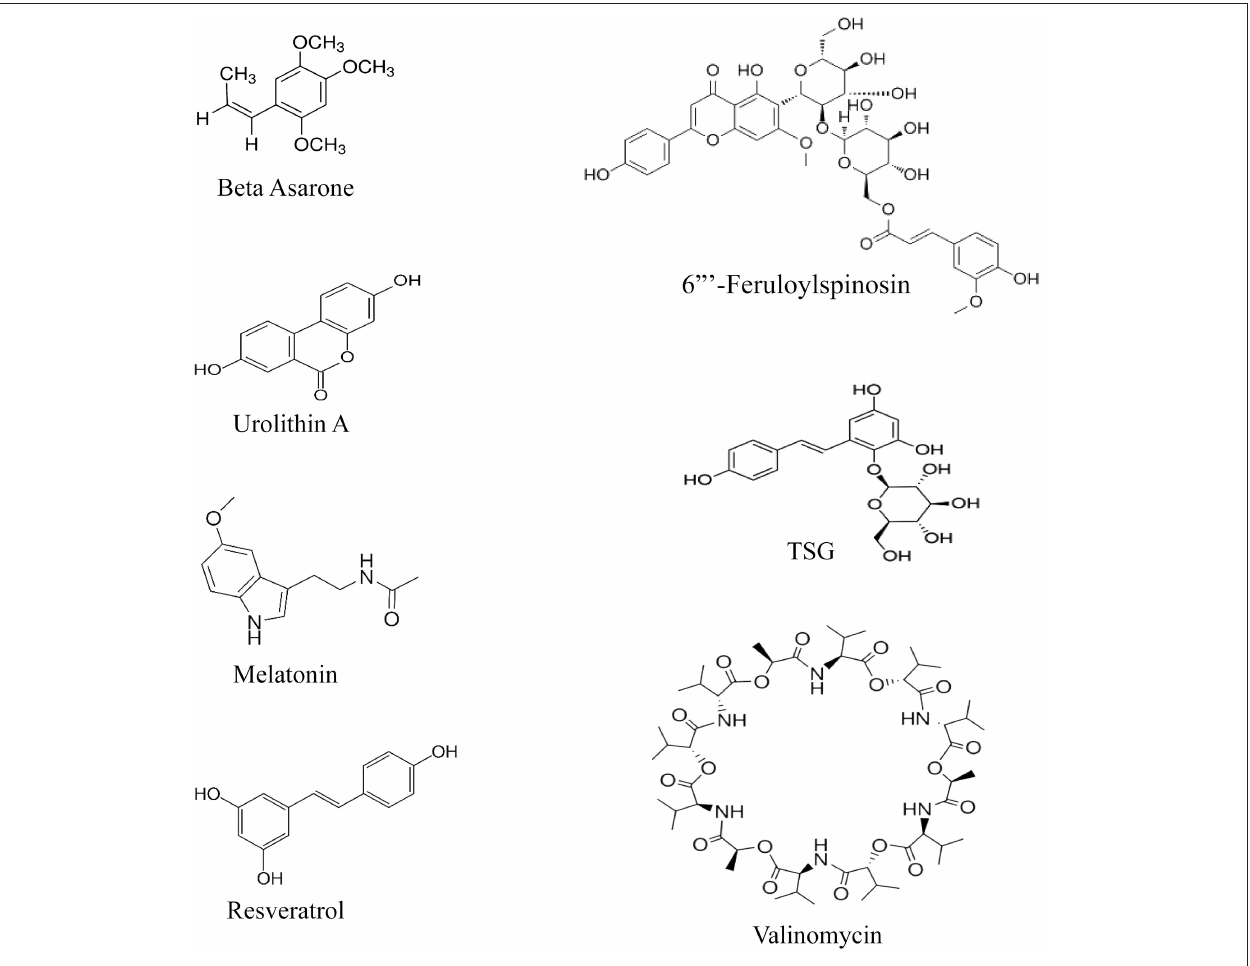
FIGURE 4 | Chemical structures of the enhancers of the PINK/Parkin